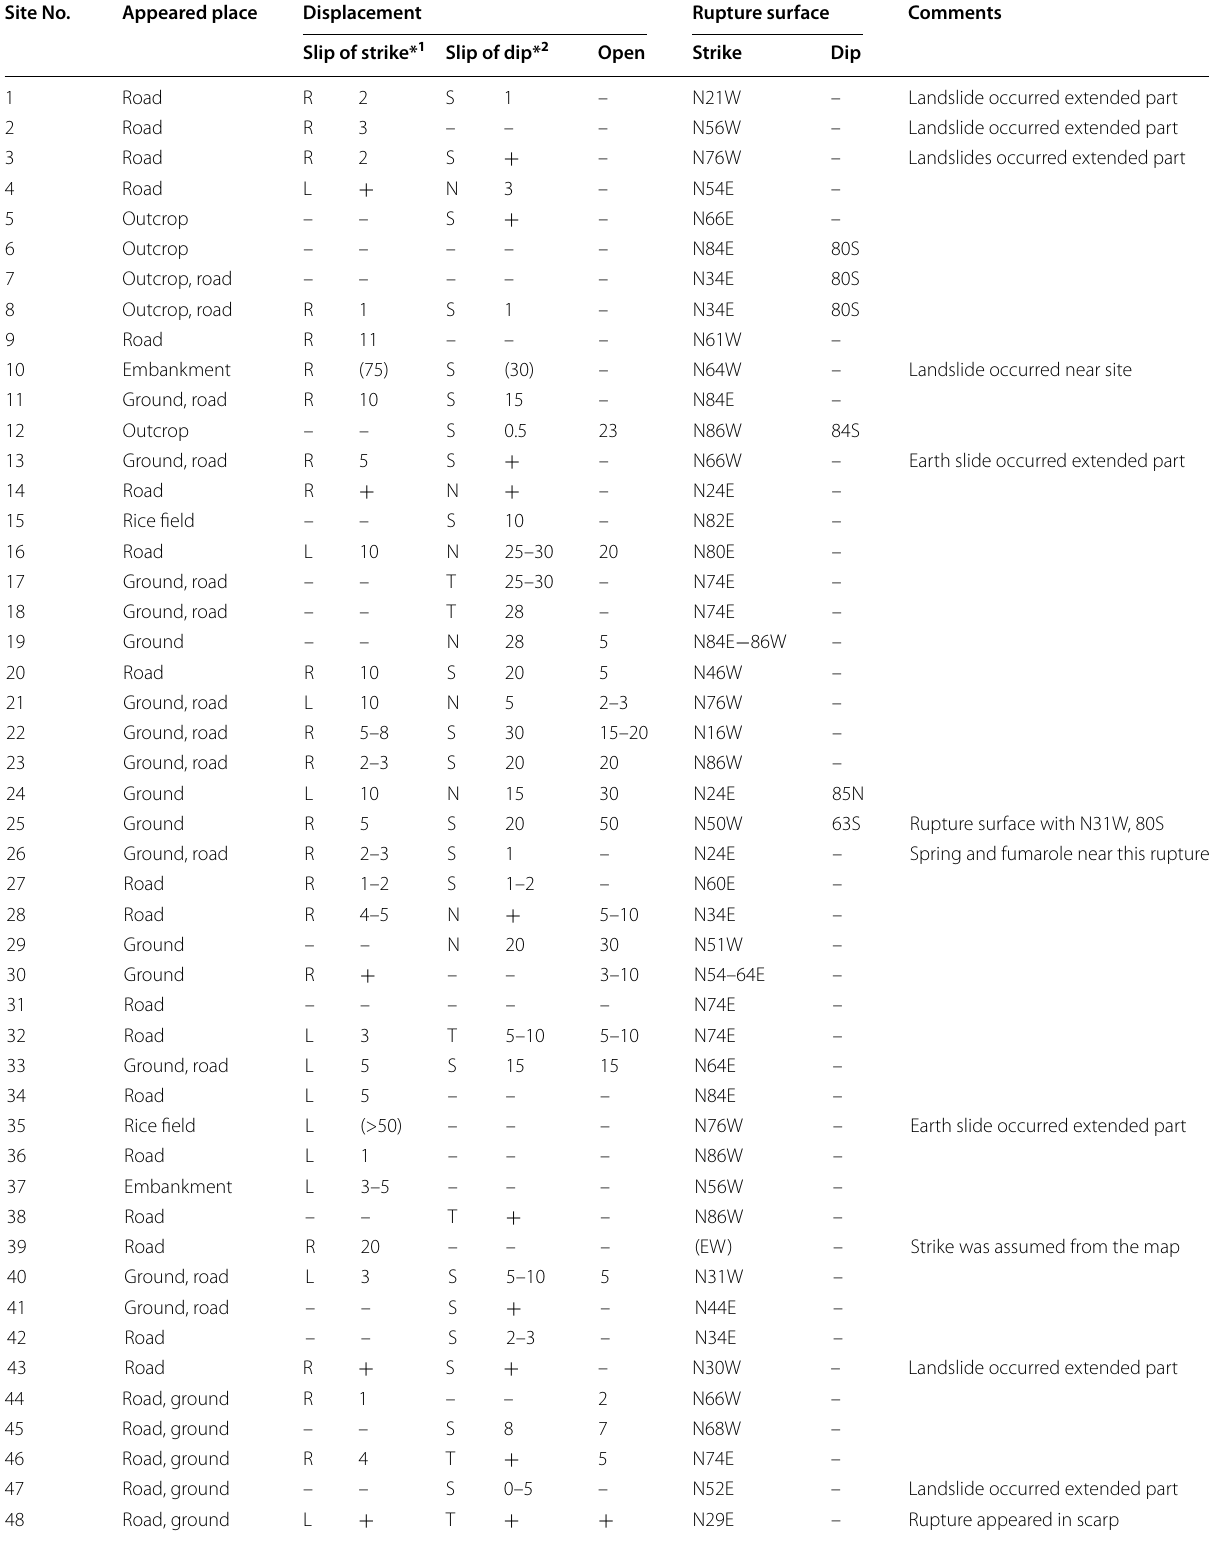
Table 1 List of parameters for rupture displacement Site